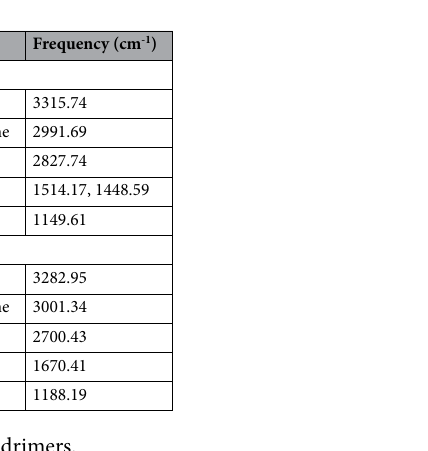
Figure 6. UV–Vis absorption spectra obtained from different generations of PAMAM dendrimer in methanol ( a ) half generation; ( b ) full generation.